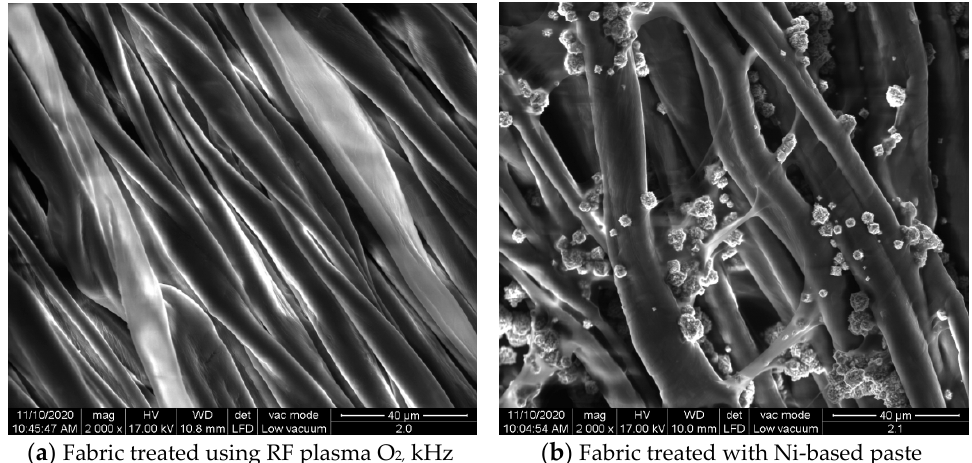
Figure 4. The sample was treated using RF 2 plasma O 2 using kHz generator and power 50 W. ( a ) represents the image of the sample treated using RF plasma O 2 kHz and power 50 W, respective ( b ) represents the sample treated with Ni-based